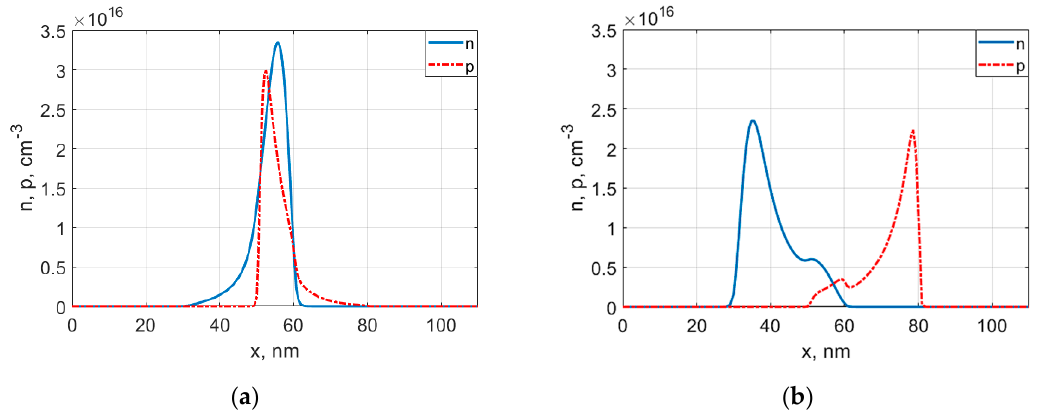
Figure 5. The spatial overlap ( a ) and separation ( b ) of electron ( n ) and hole ( p ) density peaks in the control heterostructure of the photodetector with controlled relocation of carrier density peaks (20-nm LT/10-nm i -type/20-nm LT configuration).